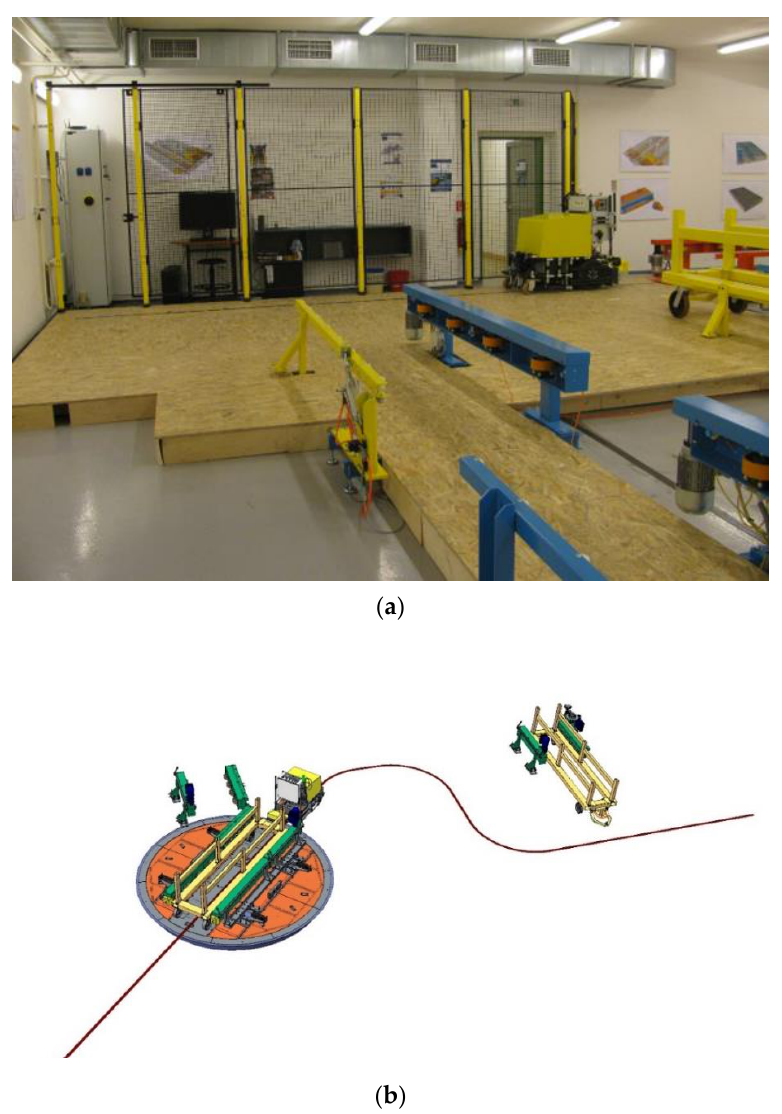
Figure 4. ( a ) Prototype of the logistics system based on the modular principle; ( b ) virtual verification of the system.